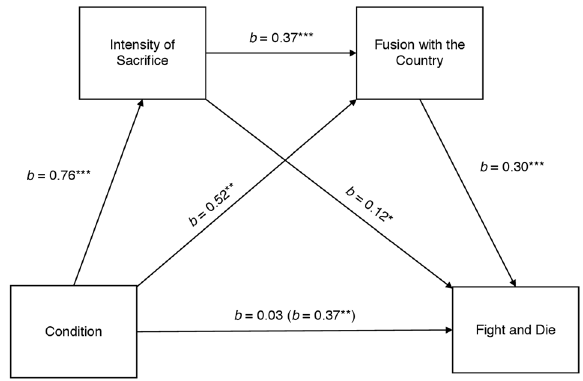
Fig. 2 Linear mediation model in Study 2 ( N = 152). Admiration for an ingroup member increased willingness to fi ght and die via (1) intensity of sacri fi ces alone, b = 0.10, 95% CI [0.03, 0.20], (2) identity fusion alone, b = 0.16, 95% CI [0.05, 0.30], and (3) intensity of sacri fi ce and fusion with country serially, b = 0.08, 95% CI [0.03, 0.17]. (Study 2). Note: * p <